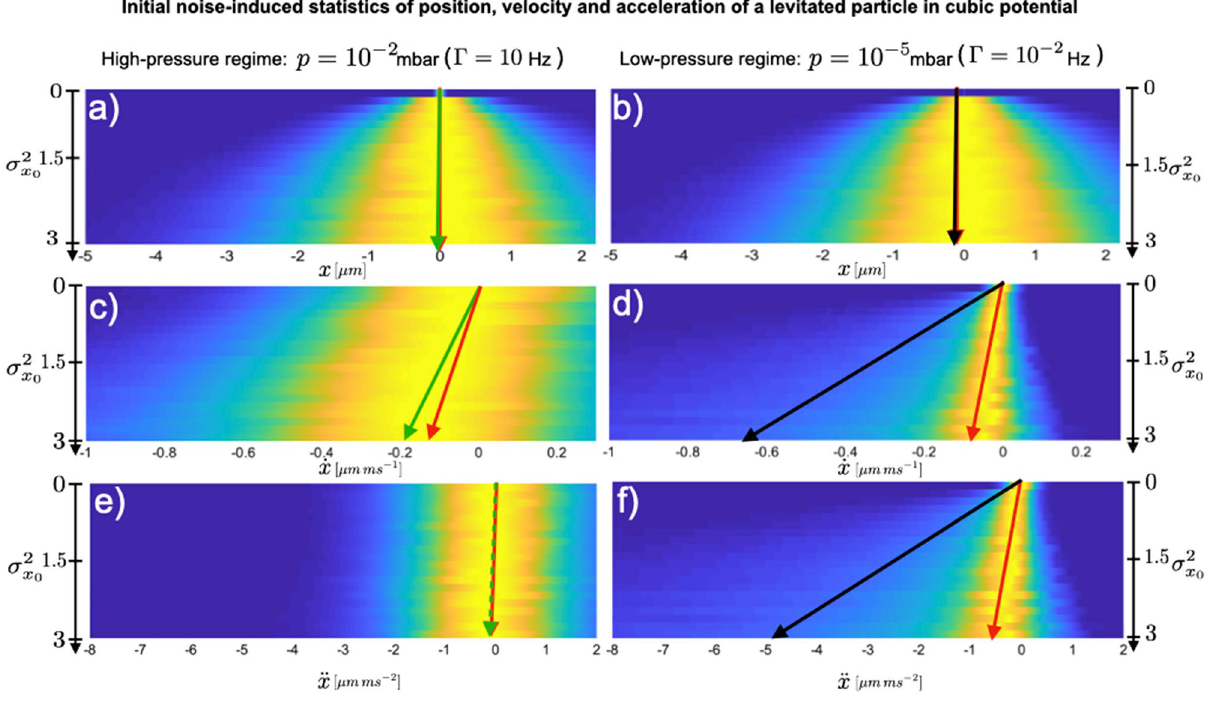
Figure 1. Uncertainty-induced position, velocity and acceleration statistics of a levitated particle in cubic 10 − 2 mbar, (left column) and low pressure potential, for high pressure limit, corresponding to a pressure of p = 0 ms, the Gaussian 10 − 5 mbar (right column). At initial time t limit, corresponding to a pressure of p = = x 0 0 , while σ 2 distributions of particle position has x 0 triggers the nonlinear dynamics. In all cases, the � � = x 0 0 . The initial position and speed 0 and σ 2 Gaussian distribution of particle instantaneous speed has x 0 = �˙ � = ˙ are statistically independent. In the top panel, for both high pressure limit (a) , and low pressure limit (b) , the x mean of particle position (green, black) does not develop at short time scales, with increasing initial position (cid:31) (cid:30) uncertainty σ x , but its standard deviation σ x increases with it (green-blue halo). The maximum of position 0 distribution x max (red) does not develop either with increasing initial position uncertainty. In the middle � x /� t distribution v panel, for the high pressure limit (c) , the shift of the maximum of average velocity ¯ = v (red) increases alongside the mean of average speed (green). While the maximum of instantaneous velocity �¯ � x dx / dt distribution, in the low pressure regime (d) does not increase compared to its high pressure ˙ = x counterpart, the mean of instantaneous speed (black), produces a larger uncertainty-induced shift than in the �˙ � high pressure regime (green). Simultaneously, the standard deviation σ x (green-blue halo) and the uncertainty ˙ around the maximum σ x max are significantly reduced (yellow area). The bottom panel shows the evolution of ˙ particle’s acceleration statistics in both high pressure (e) and low pressure (f) limits. For the high pressure limit � a x /� t distribution (red), nor the mean of averaged (e) neither the maximum of average acceleration ¯ = ˙ a acceleration (green), , display any uncertainty-induced shift. On the other hand, in the low pressure limit �¯ � (f) , the statistics exhibits a substantial uncertainty-induced shift in the maximum of instantaneous acceleration x x d x / dt distribution (red) alongside the mean of instantaneous acceleration (black). To generate all the ¨ = ˙ �¨ � 6 k B T µ m − 3 kg − 1 , T 300 K, t 0.1 ms, dt 2 10 − 5 density plots, Eq. (1) has been simulated using κ = = = = × 10 4 trajectories where generated with 5000 samples each. To calculate the instantaneous quantities, ms. N t = 2 10 − 5 ms, whereas for the x dx / dt , x d x / dt , the time interval used is given by the time-step dt = × ˙ = ¨ = ˙ � x /� t , � v /� t , the time interval, multiple of the time-step, has been used v a average quantities ¯ = ¯ = (cid:31) t dt 10 = ×